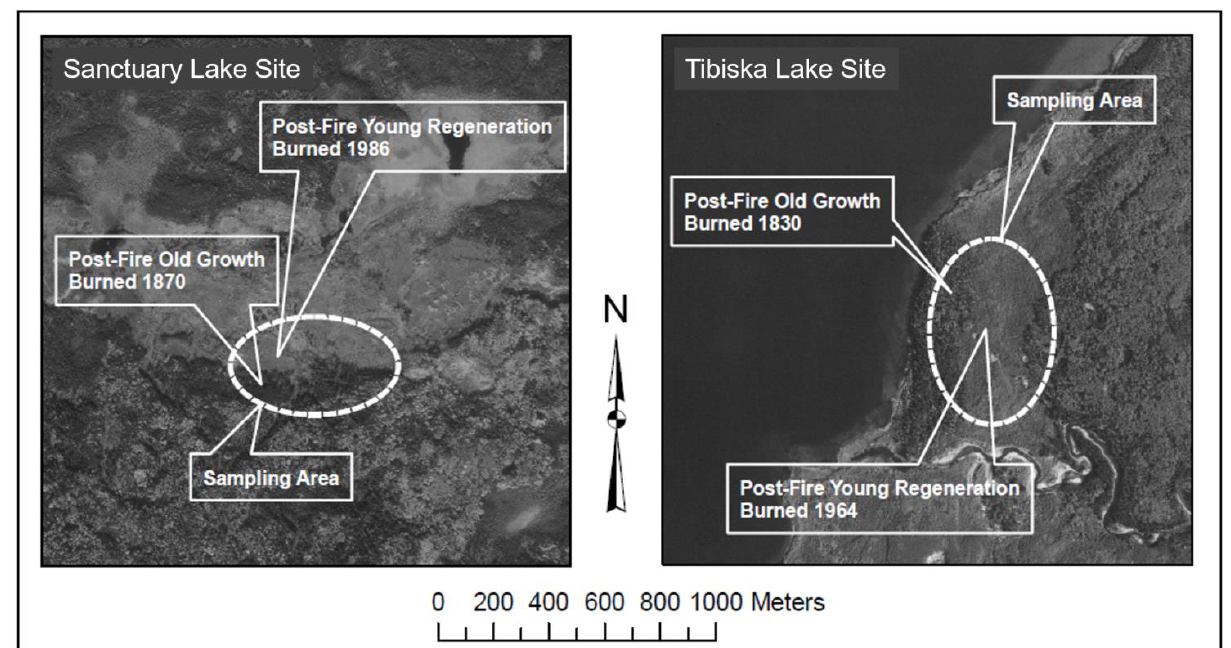
Figure 1. The 1999 aerial photos showing post-fire old growth and post-fire young regeneration at the Sanctuary Lake site ( left ) and Tibiska Lake site ( right ).